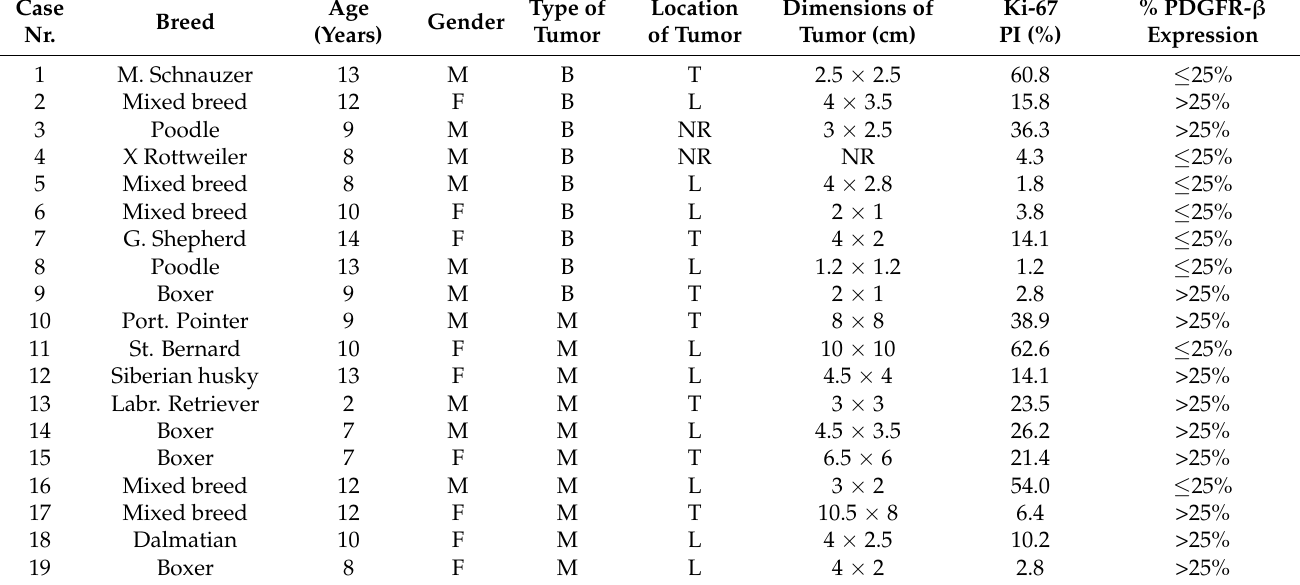
Table 1. Clinical data, type of tumor, Ki-67 index and percentage of PDGFR- β expression in dogs with cutaneous